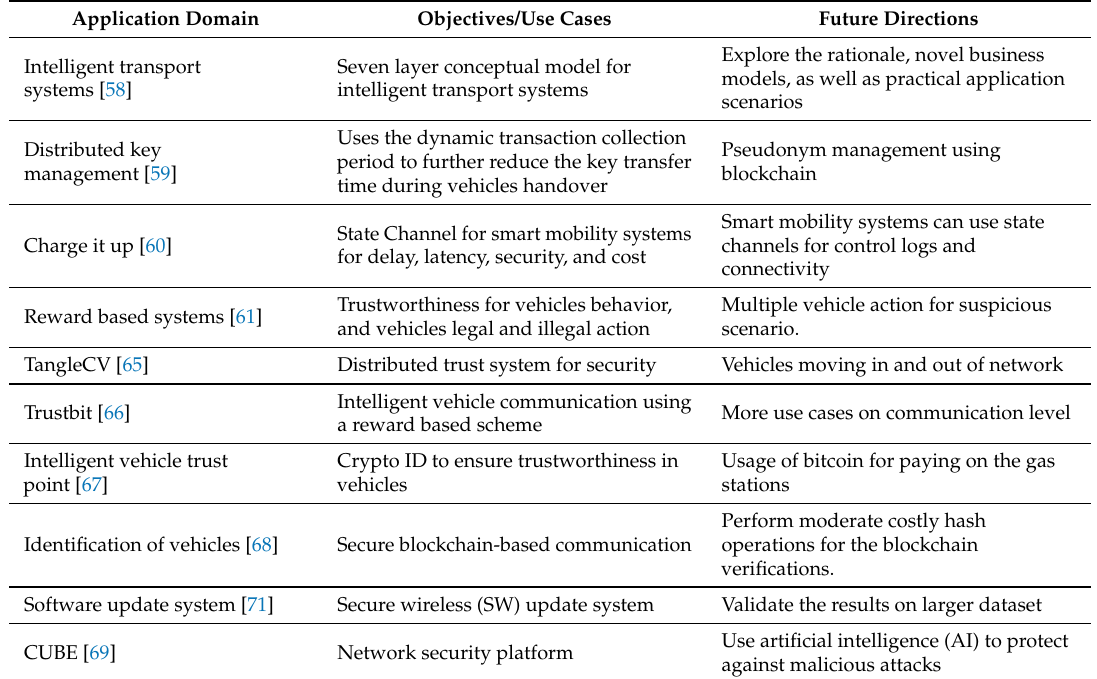
Table 4. Use cases, design challenges, and future directions in